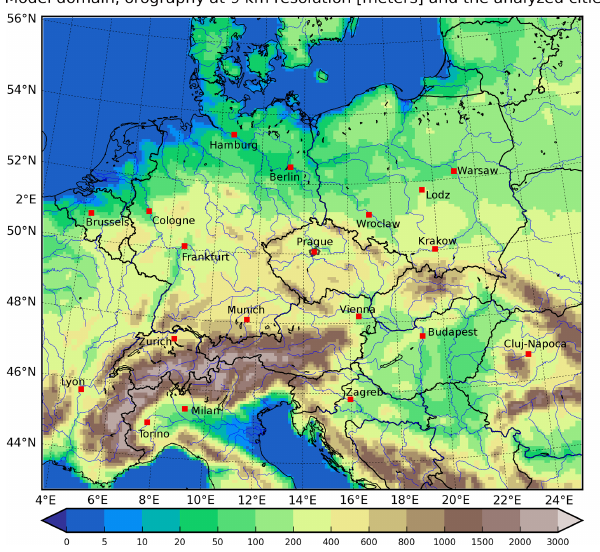
Figure 1. The 9km × 9km resolution model domain and the re- solved terrain in meters including the cities analyzed in the study (red